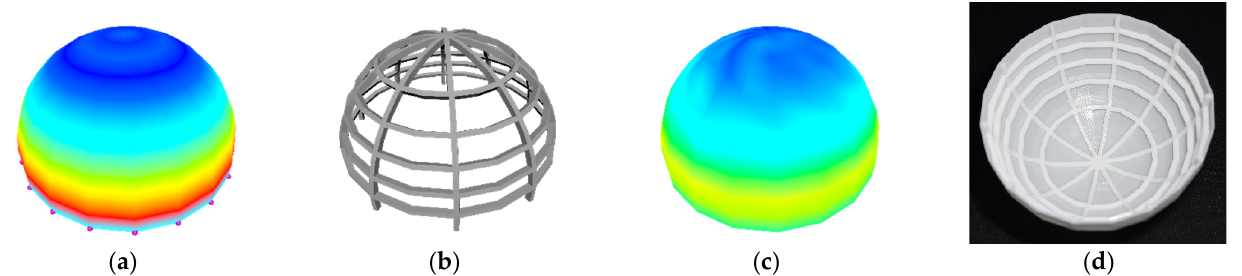
Figure 15. Bidirectionally stiffened hemisphere, from left to right: ( a ) initial stress without stiffeners; ( b ) optimized stiffeners; ( c ) final stress with stiffeners; ( d ) 3D print.